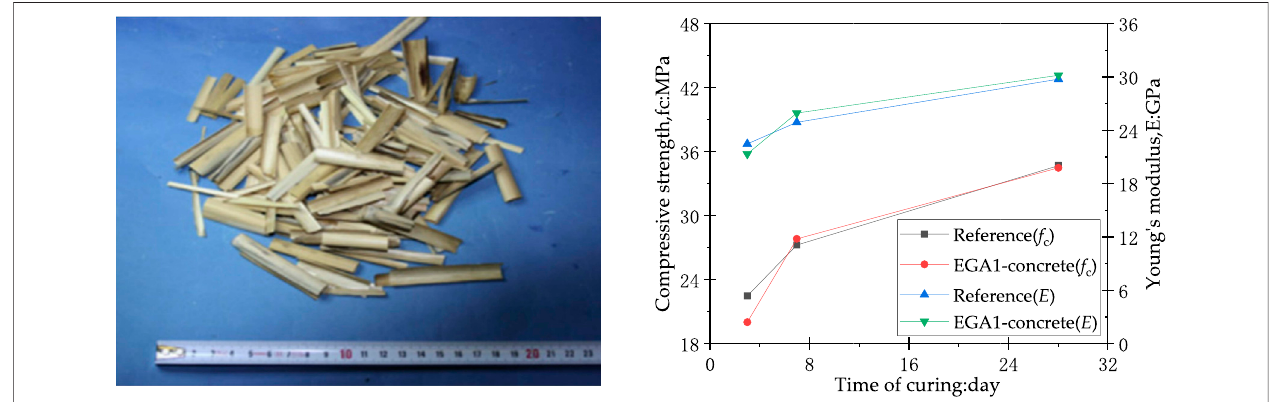
FIGURE 6 | Compressive strength ( f c ) and young ’ s modulus ( E ) of concretes up to 28 days of curing (Merta and Tschegg, 2013; Cordeiro and Sales, 2015).